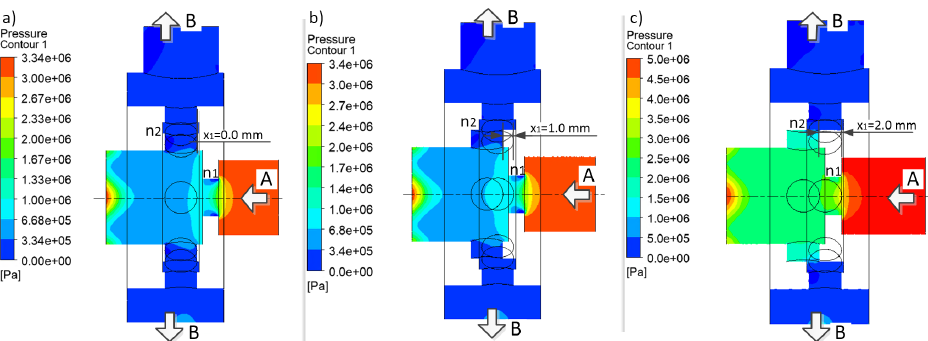
Figure 6. Pressure distribution depending on the spool position: ( a ) x 1 = 0.0 mm, ( b ) x 1 = 1.0 mm, ( c ) x 1 = 2.0 mm; A—inflow port; B—outflow port; n 1 , n 2 —nozzles.